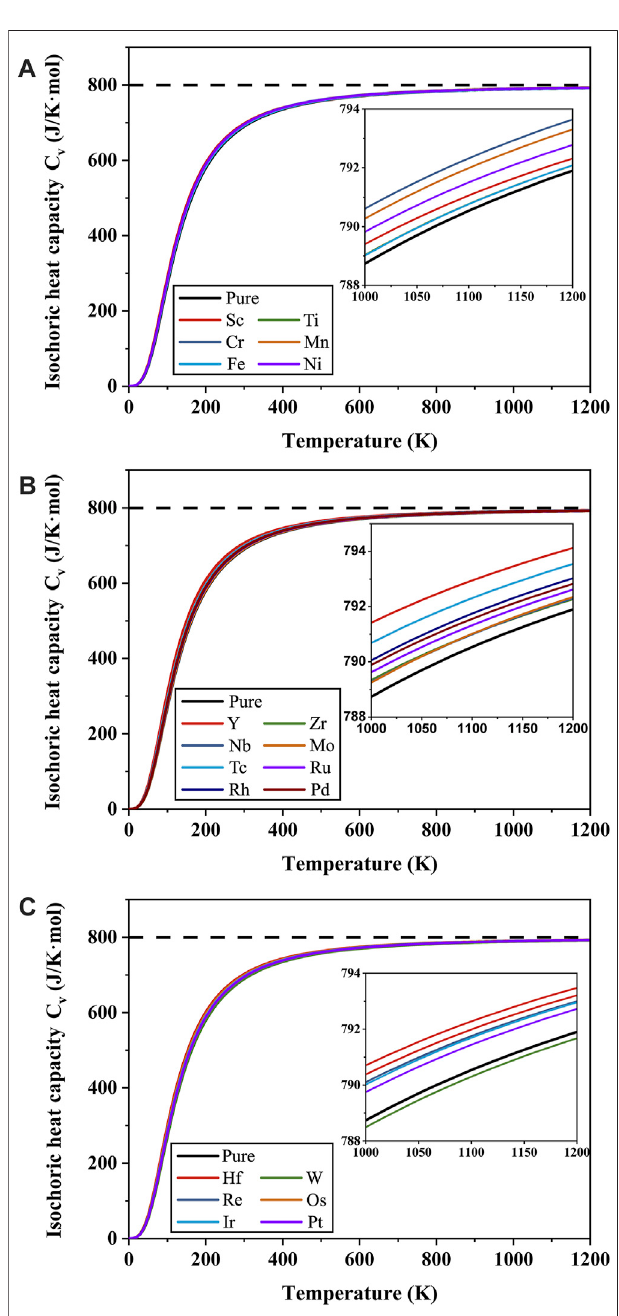
FIGURE 9 | Isochoric heat capacity C v of γ ′ -Co 3 (V, Ta) doped with (A) 3d elements, (B) 4d elements, and (C) 5d